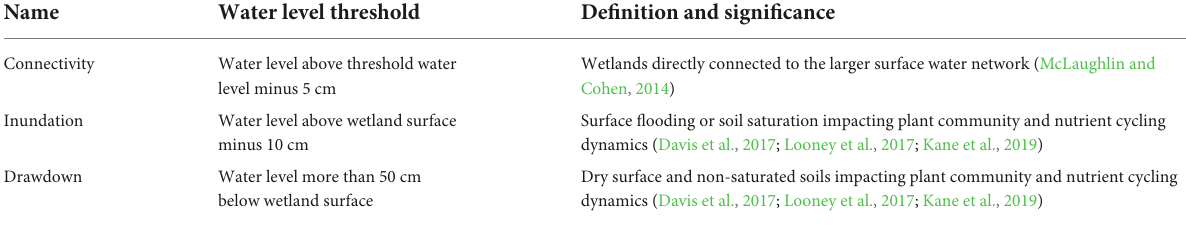
TABLE 3 Water level thresholds and definition of three conditions considered as critical ecohydrological